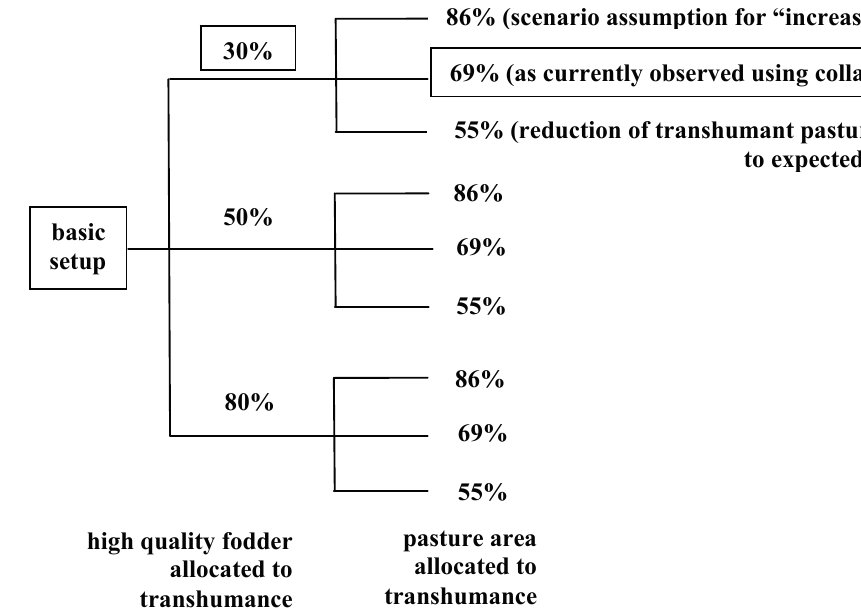
Figure 6. Fodder and pasture allocation scenarios (FPAs) as used in the LDM. Framed parameterizations are most plausible for present conditions.